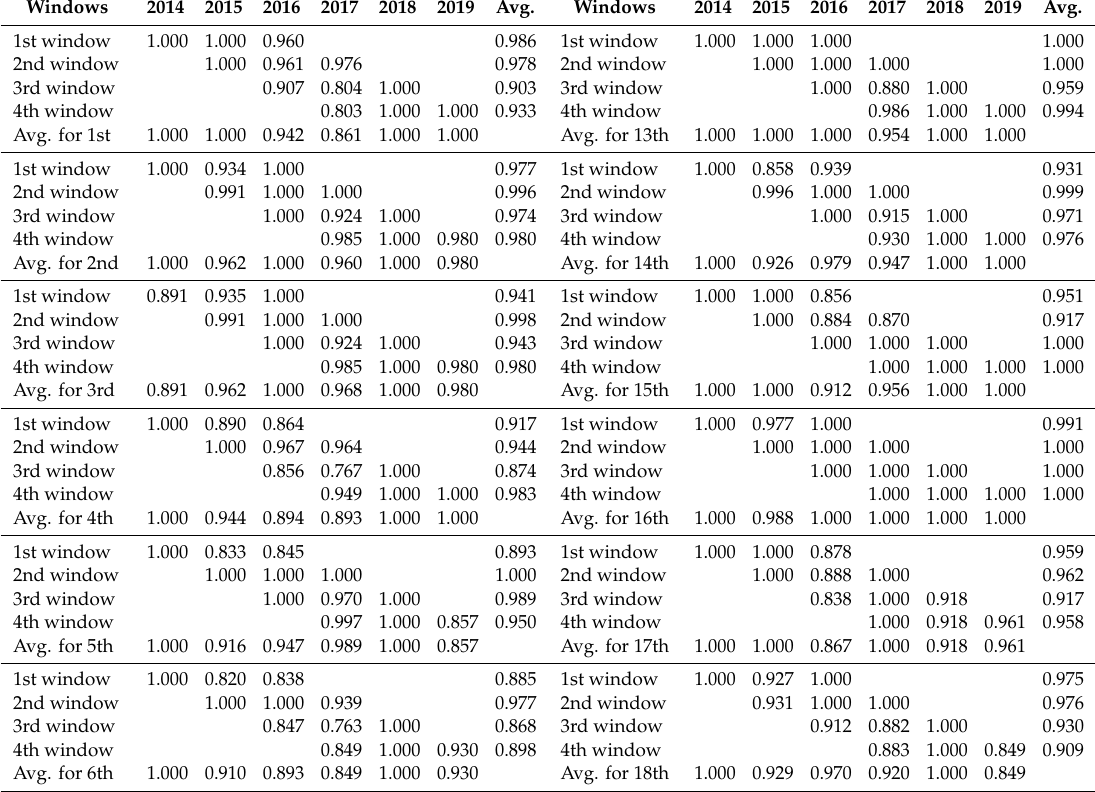
Table 8. Window analysis for BCC